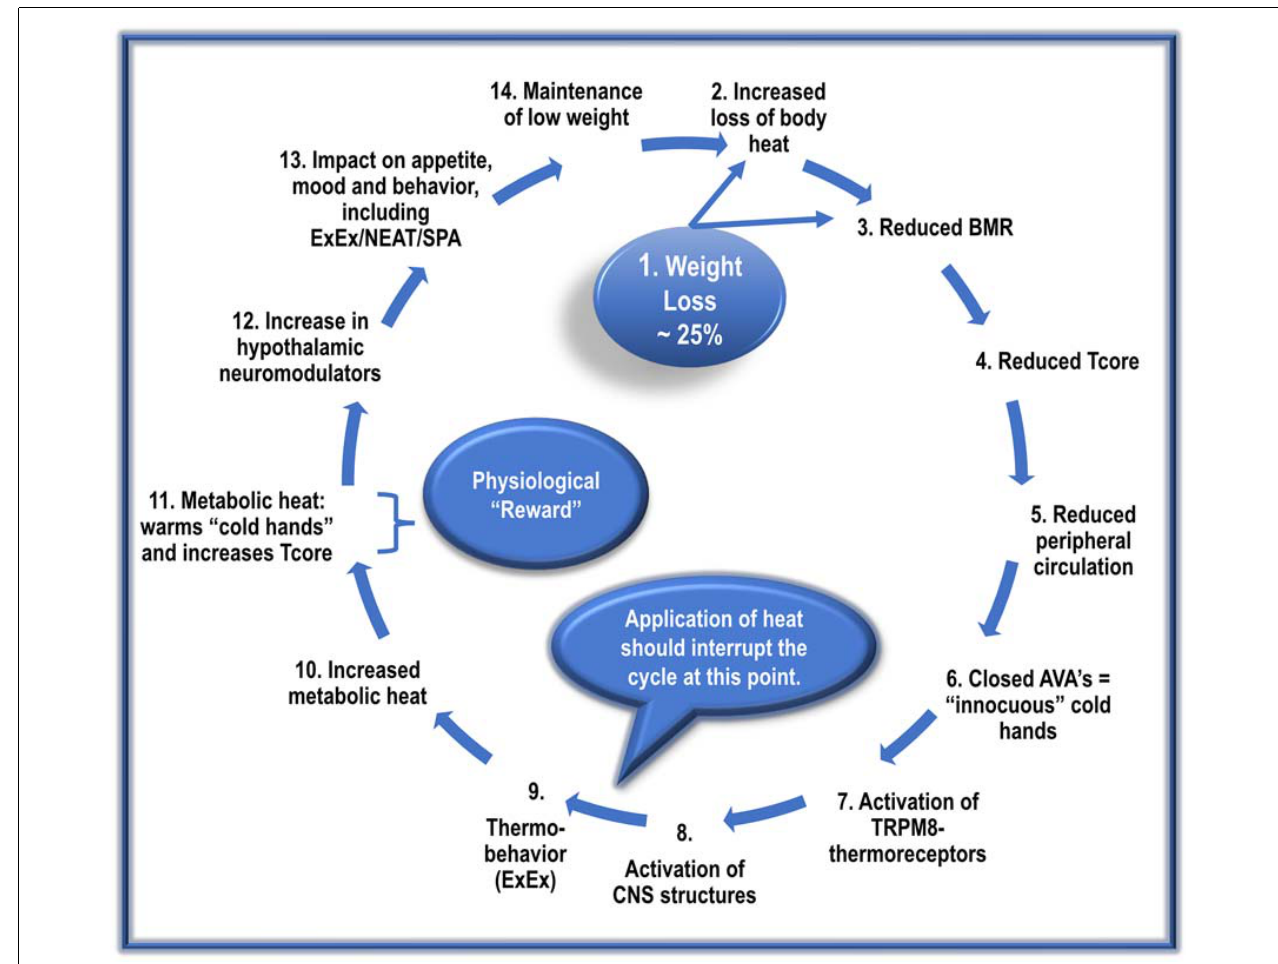
FIGURE 3 | The proposed cyclic events, with repetition, manifest in the development and maintenance of